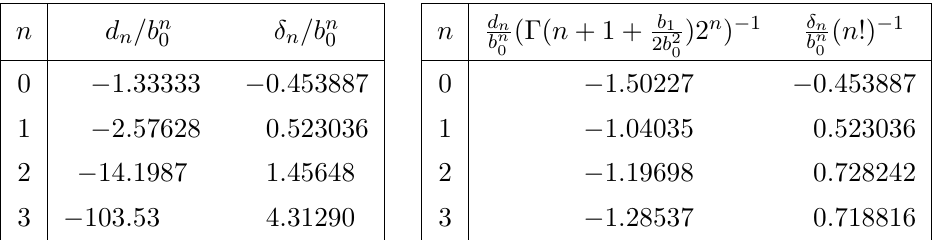
Table 3 . Original perturbative coe(cid:14)cient d n and renormalon subtracted perturbative coe(cid:14)cient (cid:14) n . In the right panel, we divide d n by the large order behavior expected from the u = 1 = 2 renormalon, and divide (cid:14) n by n !. We take n f = 3.